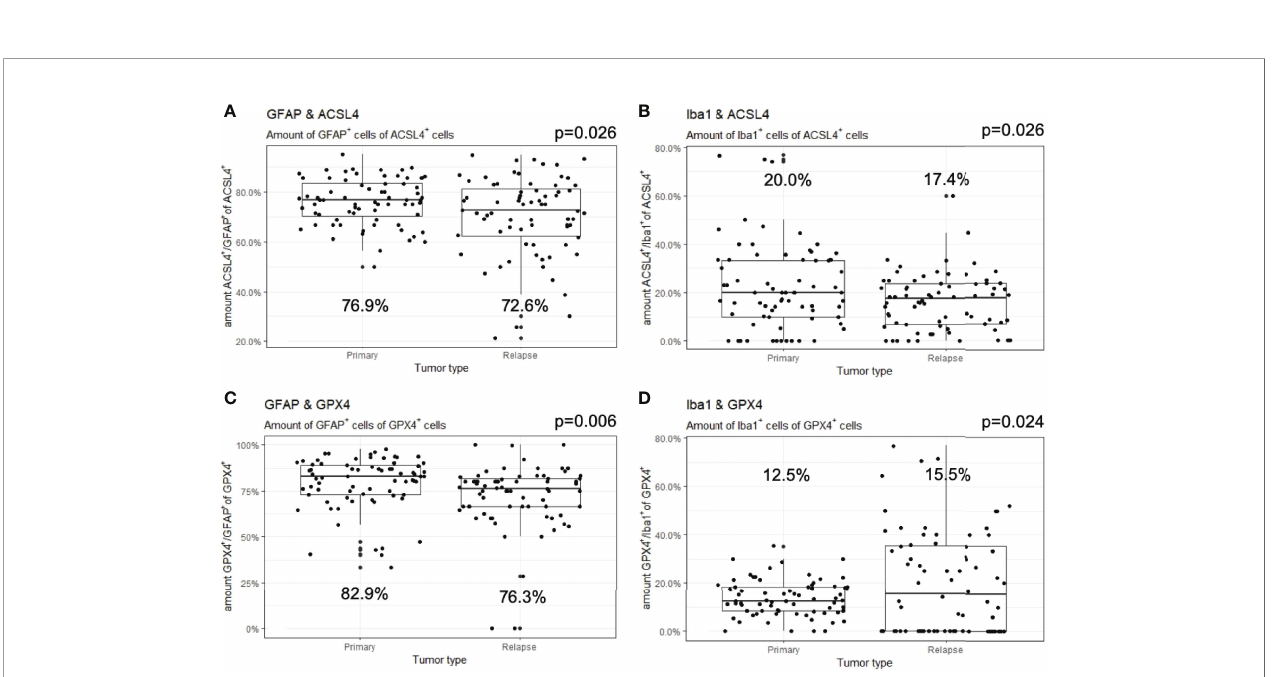
FIGURE 5 | Co-expression of GFAP and Iba1 with ACSL4 and GPX4. Given are the numbers of GFAP + or Iba1 + cells of ACSL4 + or GPX4 + cells. The dots indicate the amounts of each patient in the primary and relapse tumor. (A) The number of GFAP + /ACSL4 + cells decreases insigni fi cantly in the relapse. (B) The amount of Iba1 + /ACSL4 + cells signi fi cantly decreases in the relapse. (C) The number of GFAP + /GPX4 + cells decreases signi fi cantly in the relapse. (D) The amount of Iba1 + / GPX4 + cells increased signi fi cantly in the